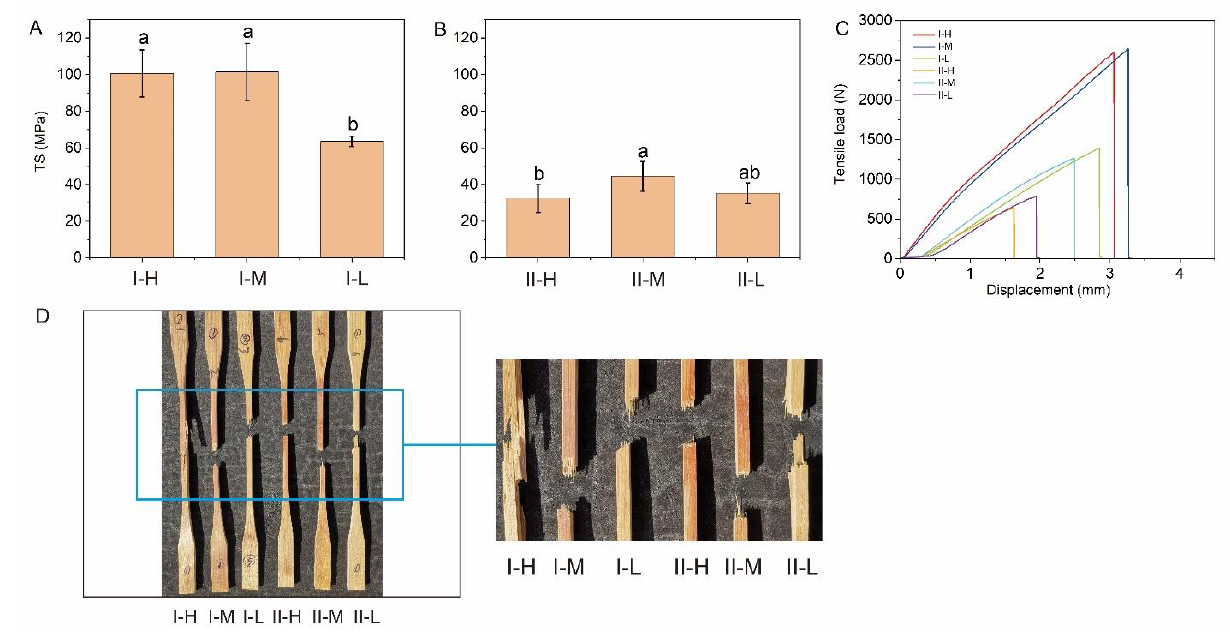
Figure 6. ( A , B ) Tensile properties of bamboo laminated composites ( BLCs) by type; ( C ) tensile load – displacement curves of the distinct types of BLC; and ( D ) observed modes of failure and their components. Different letters within a column indicate significant differences as determined by Duncan’s multiple range test ( p < 0.05).